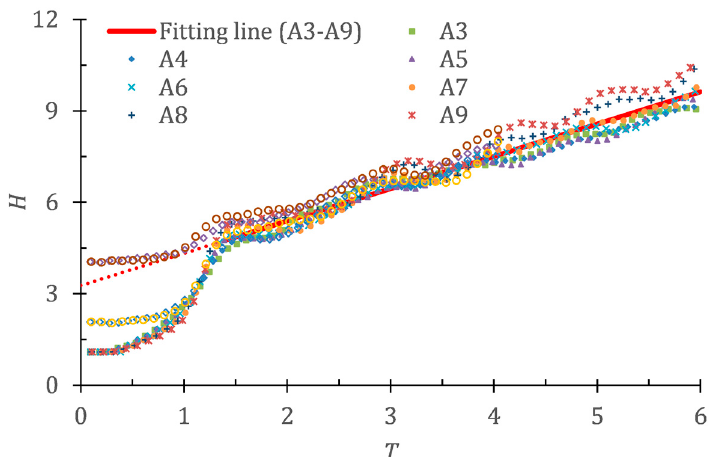
Figure 21. Dimensionless change in the thickness of the pycnocline varies with time for Cases A3~A9 ( Fr p = 2.26~4.77) and B1~B2 ( Fr p = 2.83) and B3~B4 ( Fr p = 4.07). The red solid line is the fitting line when T > 1.4.